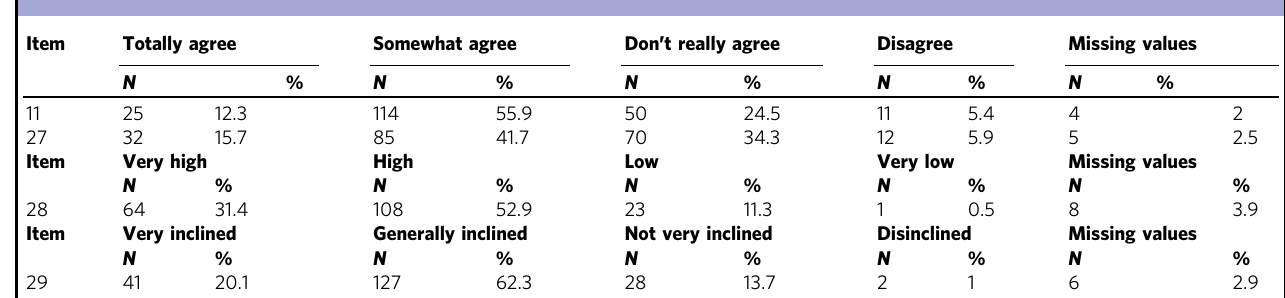
Table 6 Commitment of respondents to the paci fi cation